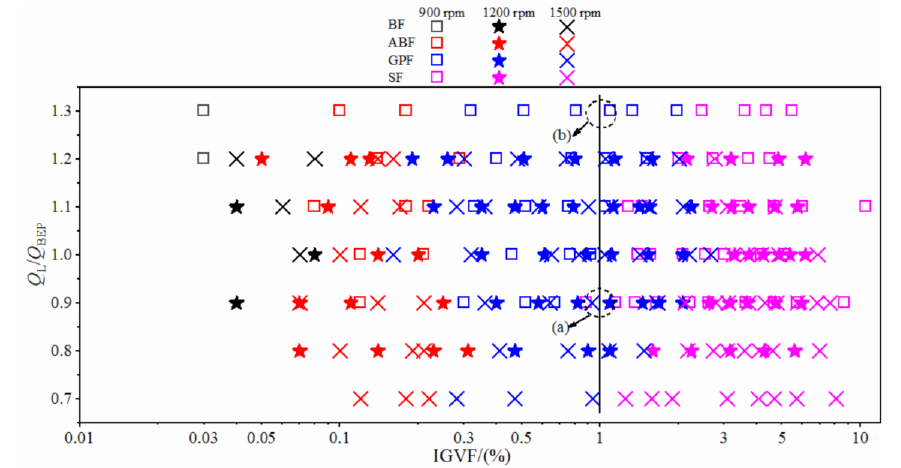
Figure 3. Flow pattern map of centrifugal pump.